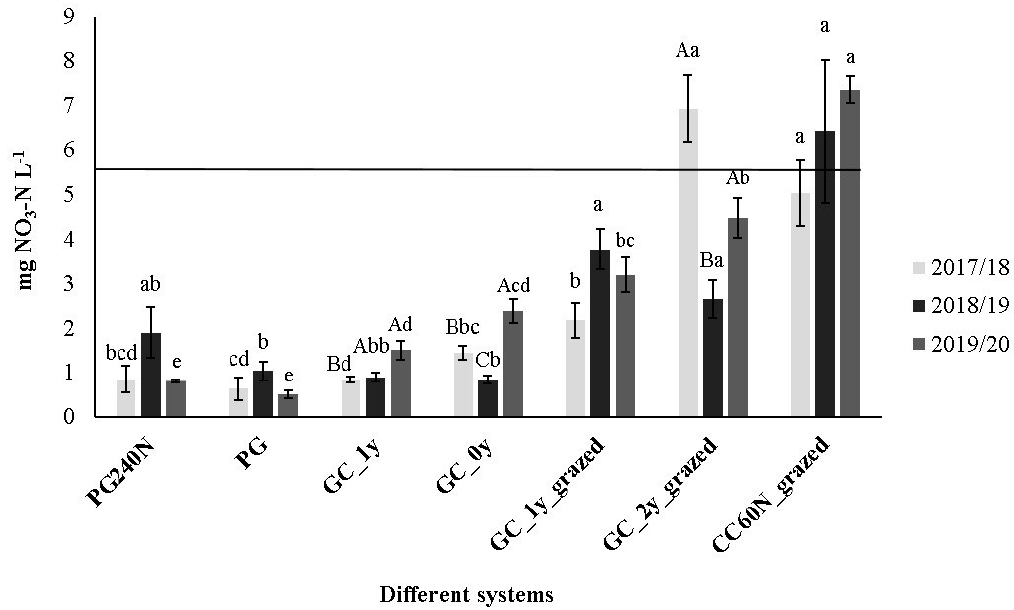
Figure 3. Average nitrate concentration in the soil water (mg L − 1 ) of the different systems investigated over three winter leachate periods (2017/2018, 2018/2019 and 2019/2020). The solid line indicates the threshold of 5.6 mg NO 3 -N L − 1 . Different upper-case letters indicate significant inter-annual differences. Different lower-case letters indicate significant differences between the various sward types. Standard errors are shown.